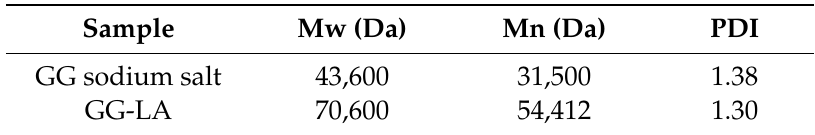
Table 1. Gellan gum (GG) sodium salt and GG-LA derivative weight average molecular weight, number average molecular weight, and polydispersity